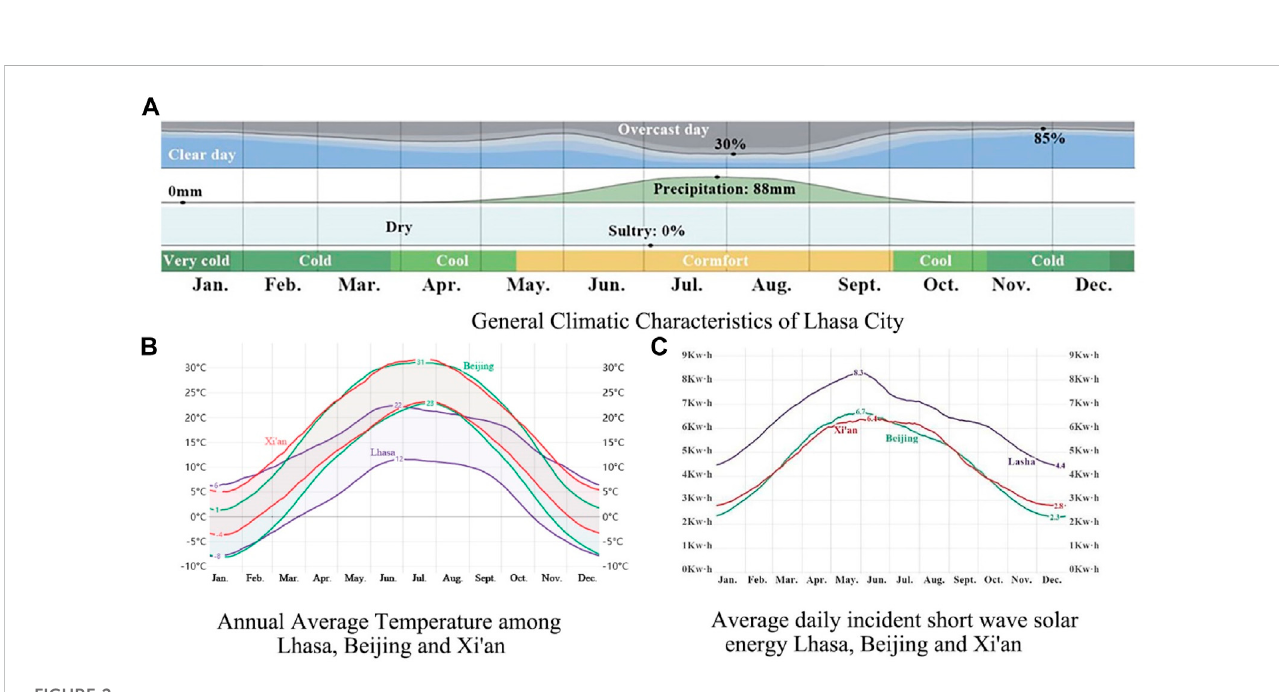
FIGURE 2 Climatic characteristics of